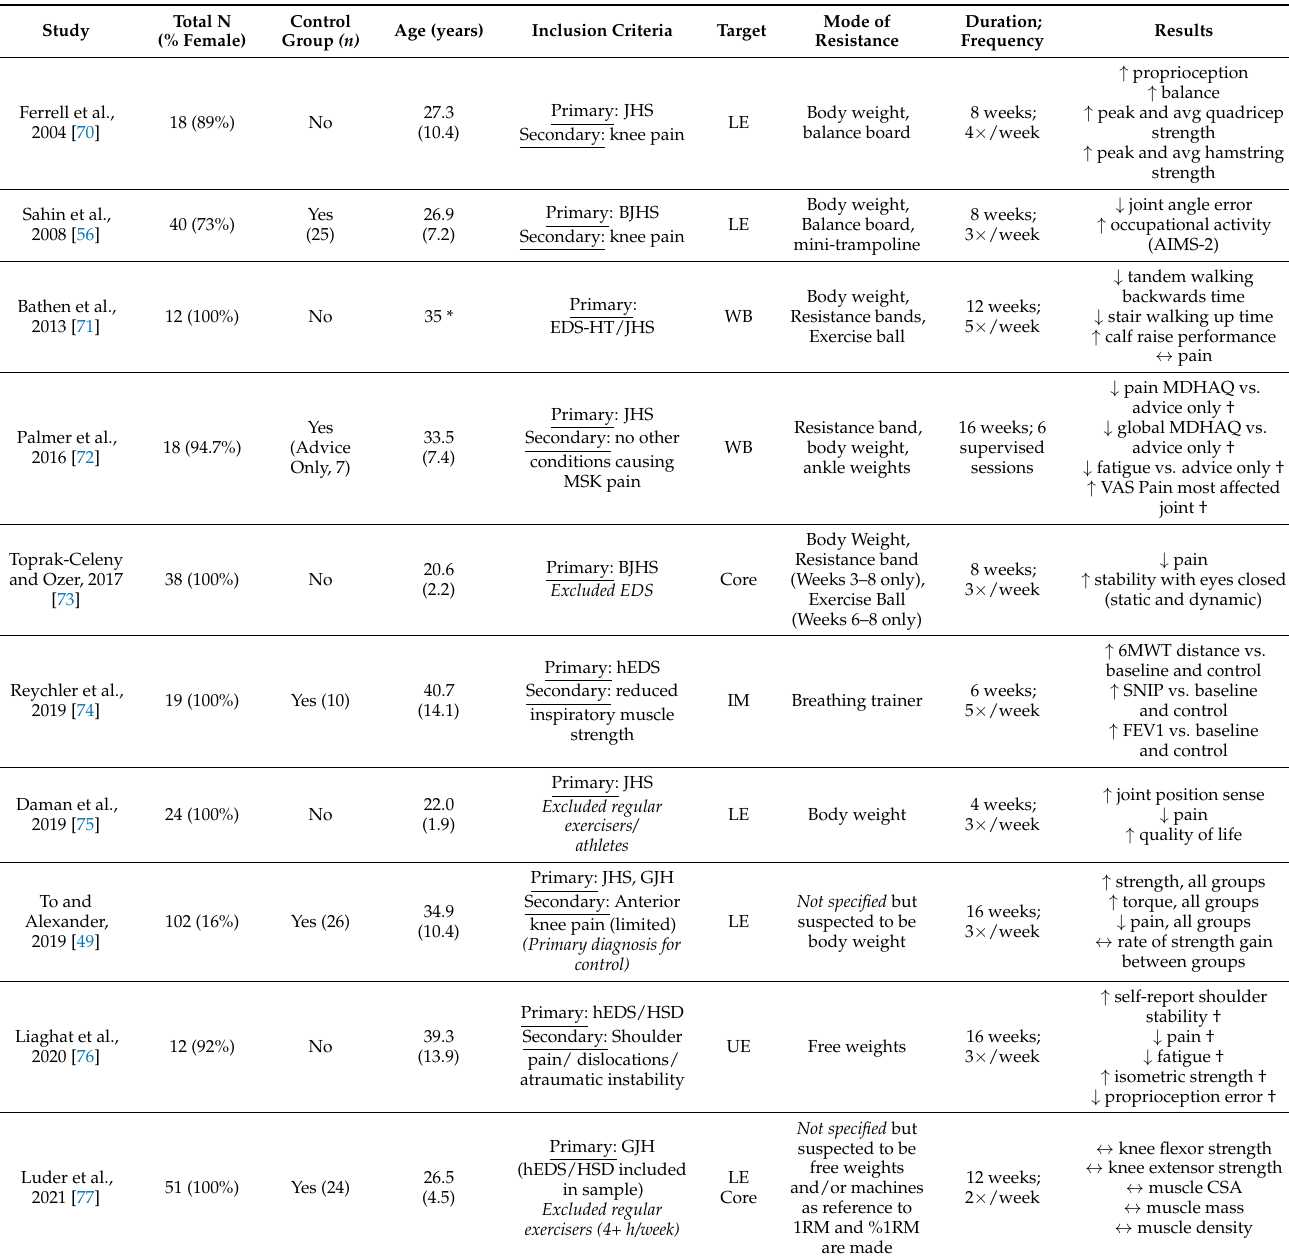
Table 3. Outcomes of Studies involving Exercise Prescription in Adults with